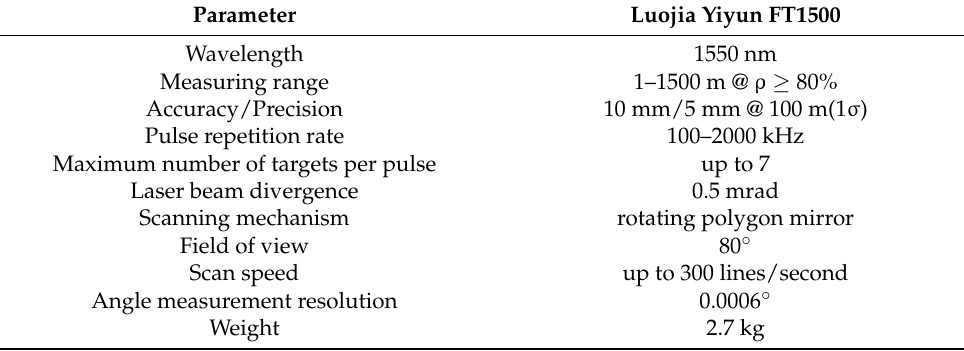
Table 1. Luojia Yiyun FT1500 system